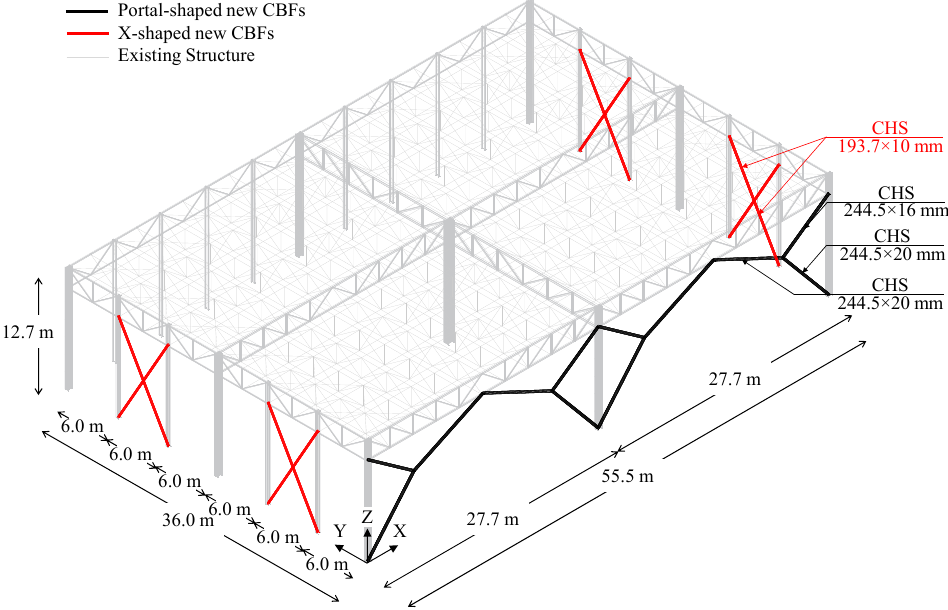
Figure 5. Description of adopted global retrofitting interventions.